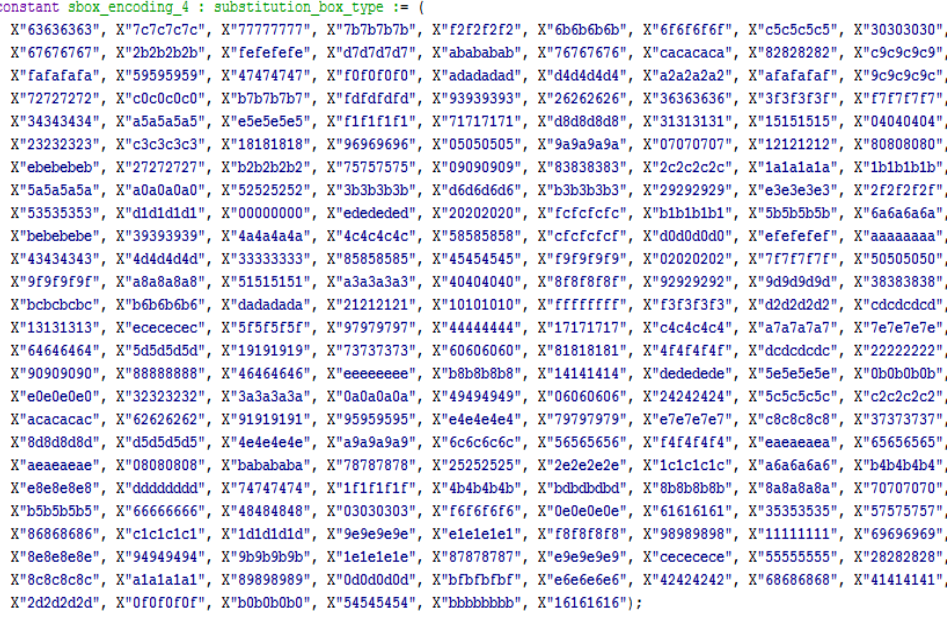
Figure 11. S-Box matrix containing 256 elements, each of 32 bit.